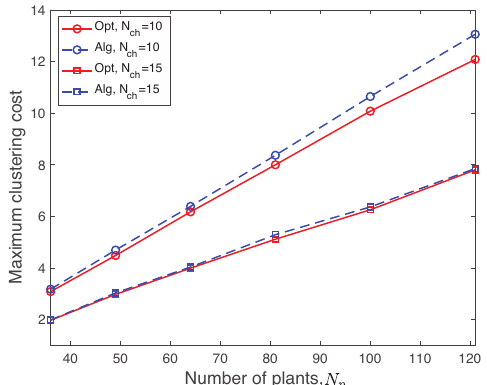
Figure 4. Maximum clustering cost by using the optimal solution and the proposed heuristic algorithm with N ch = 10,15 as a function of different number of plants N p = 36, . . . ,121. The objective value of the proposed clustering algorithm matches well the one using the optimal